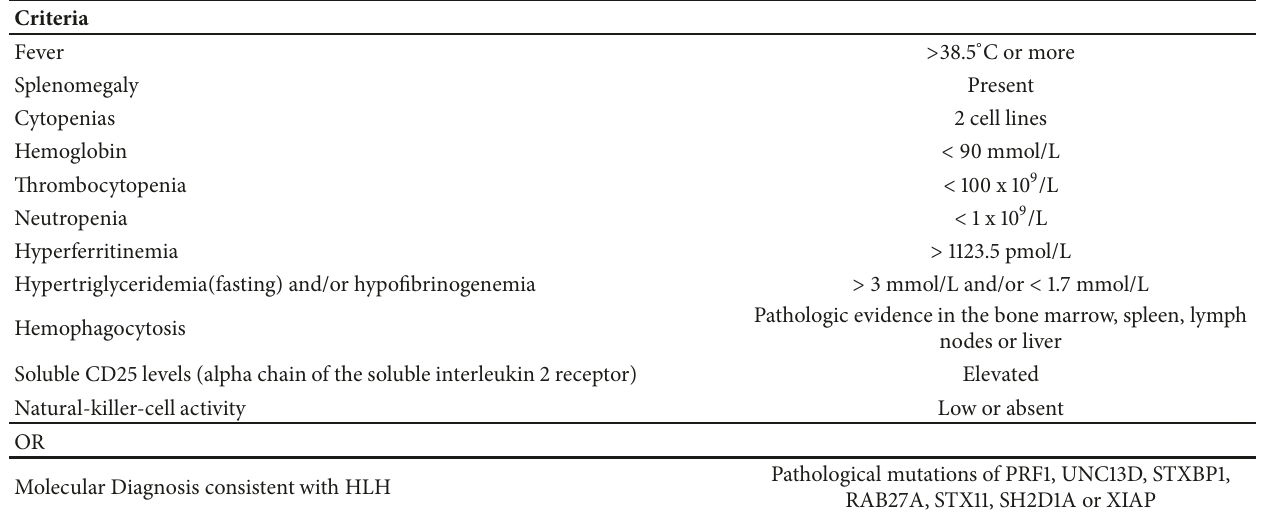
Table 1: HLH-2004 diagnostic